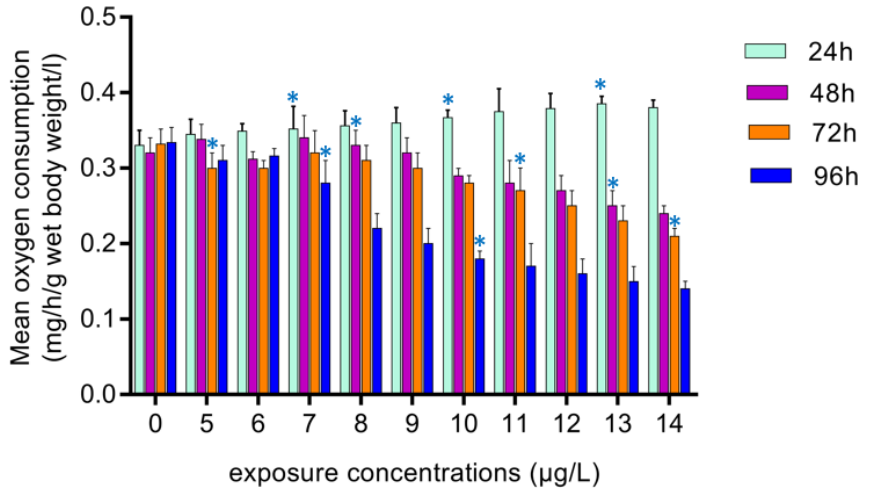
Figure 3. Mean oxygen consumption of O. mossambicus (mg/h/g wet body weight/L) exposed to various exposure concentrations of deltamethrin during various exposure periods. Asterix indicates significant differences in mean parameters ( p < 0.05) across exposure intervals for each concentration.